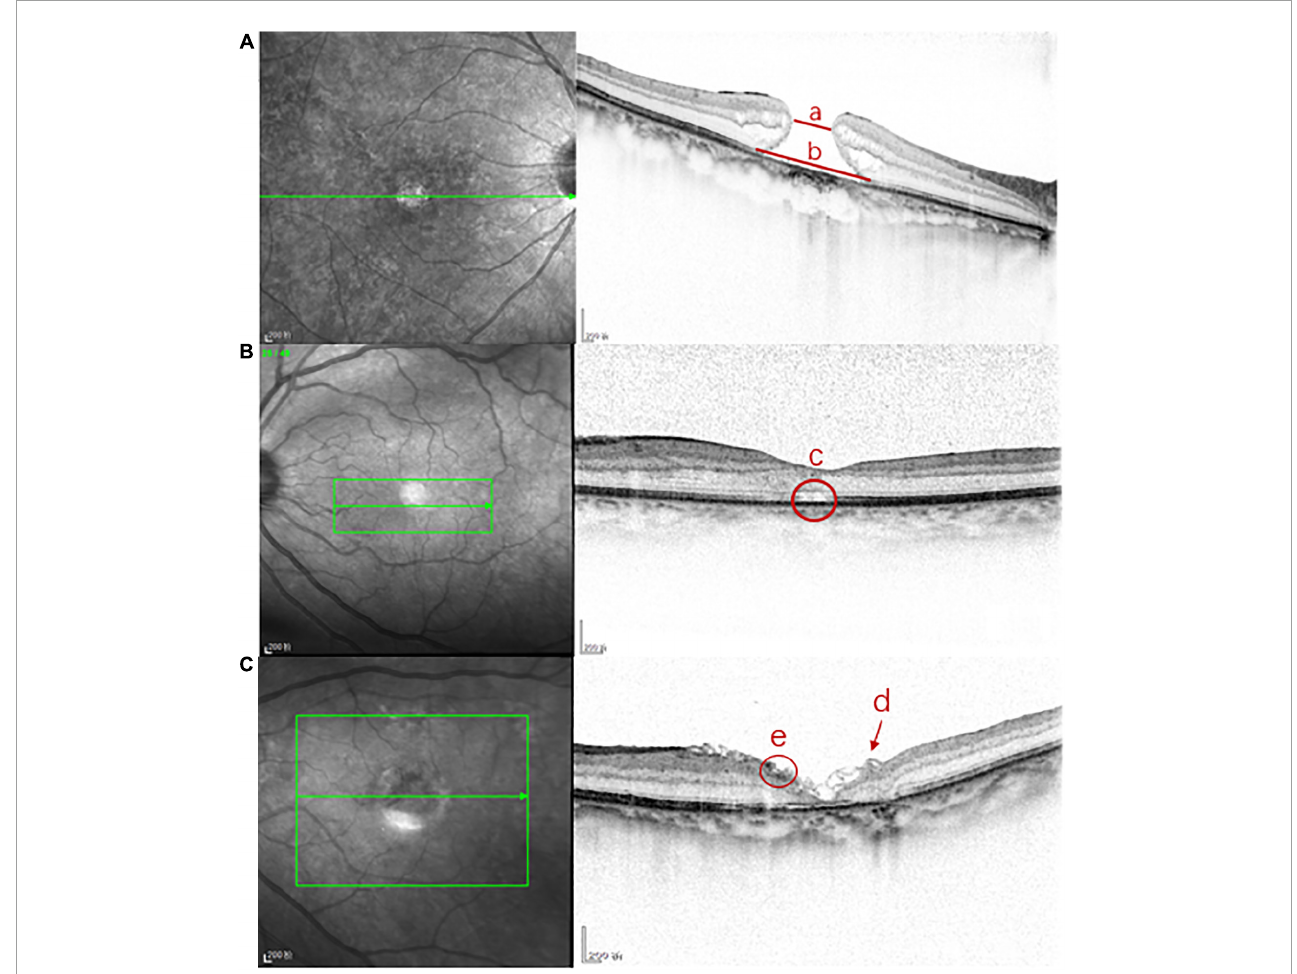
FIGURE1 The foveal microstructures in iMH were evaluated by SD-OCT. (A) Line a is the preoperative minimum diameter of iMH, line b is the preoperative length of ELM defect of iMH; (B) c is the postoperative subretinal cavity; (C) the arrow d is the postoperative ILM flap in FLAP group, the circle e is the postoperative hyperreflective change of the inner